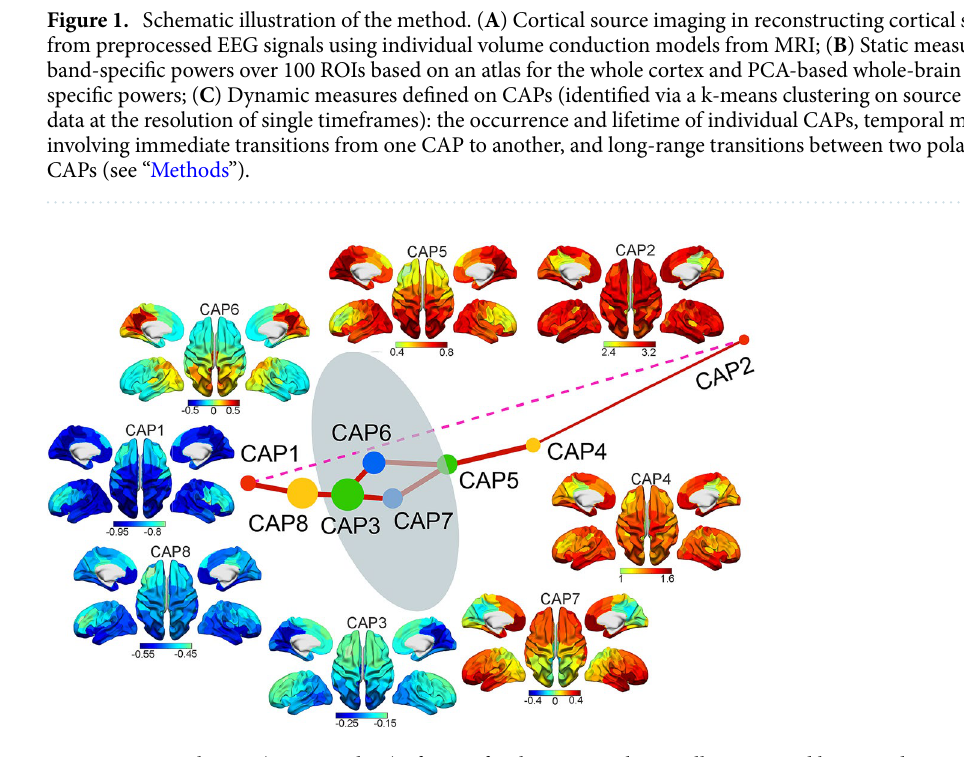
Figure 2. Spatial maps (z-score values) of a set of eight CAPs with spatially structured brain-wide patterns from resting EEG data and the distance map (via L1-norm distance) between these CAPs projected onto a 3D space. Each solid sphere in the distance map represents a CAP and its size is coded with the occurrence rate of the CAP. The same color of two spheres is coded for anti-correlated CAP pairs. The thicknesses of solid red lines are coded for high immediate transition probabilities thresholded at top 25% (see Supplementary Fig. 1) or the highest transition probability involving CAP2 (all transition probabilities involving CAP2 lower than the threshold). The dash pink line denotes the lowest transition probability between two polarized CAPs, i.e., the CAP1 and